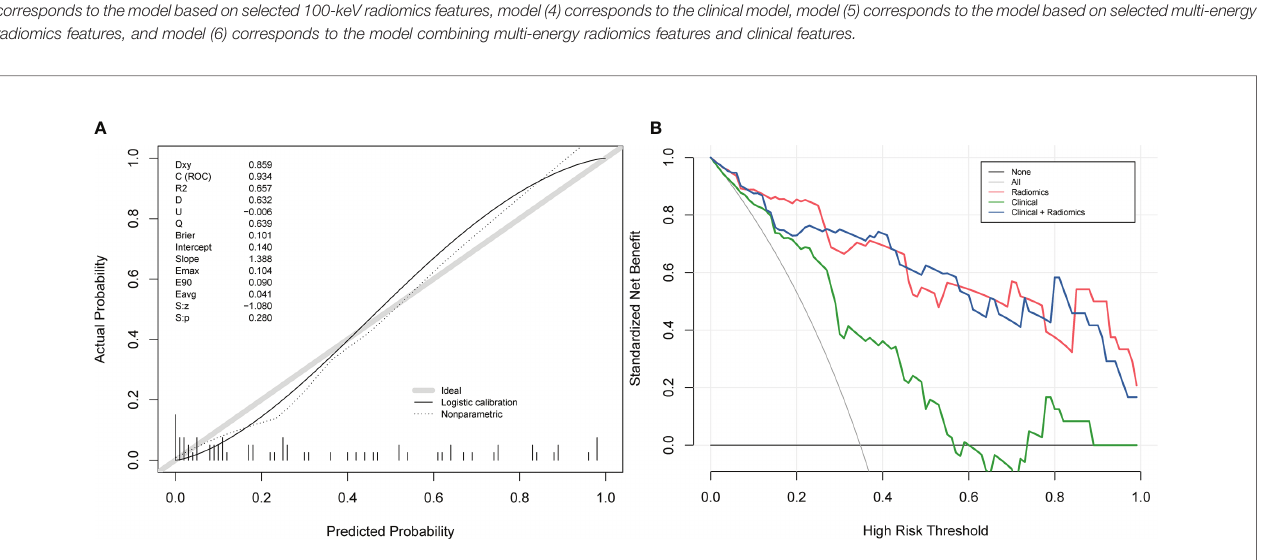
FIGURE 5 | Calibration curves and decision curve analysis of the nomogram. (A) Calibration curves of the nomogram. The x -axis and the y -axis show the nomogram-predicted response probabilities and the actual probabilities, respectively. The calibration curve presents the calibration of the nomogram in terms of the agreement between the predicted response to chemotherapy and the observed probabilities of response to chemotherapy. The diagonal gray line presents a perfect prediction, and the black solid line presents the predictive performance of the nomogram. Better prediction is indicated by a closer fi t of the black solid line to the diagonal gray line. (B) Decision curve analysis for the combined model, multi-energy radiomics model, and clinical model. The y -axis represents the net bene fi t. The gray line represents the assumption that all patients have a response to chemotherapy; however, the black line is the opposite. The blue line represents the combined model. The red line represents the multi-energy radiomics model. The green line represents the clinical